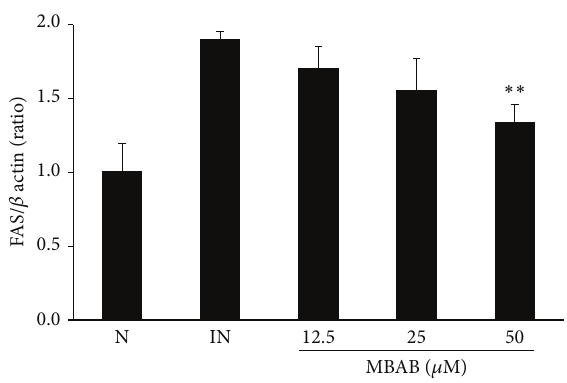
Figure 5: Effect on intracellular FAS expression. N: normal; IN: hormone mixture; MBAB: hormone mixture +